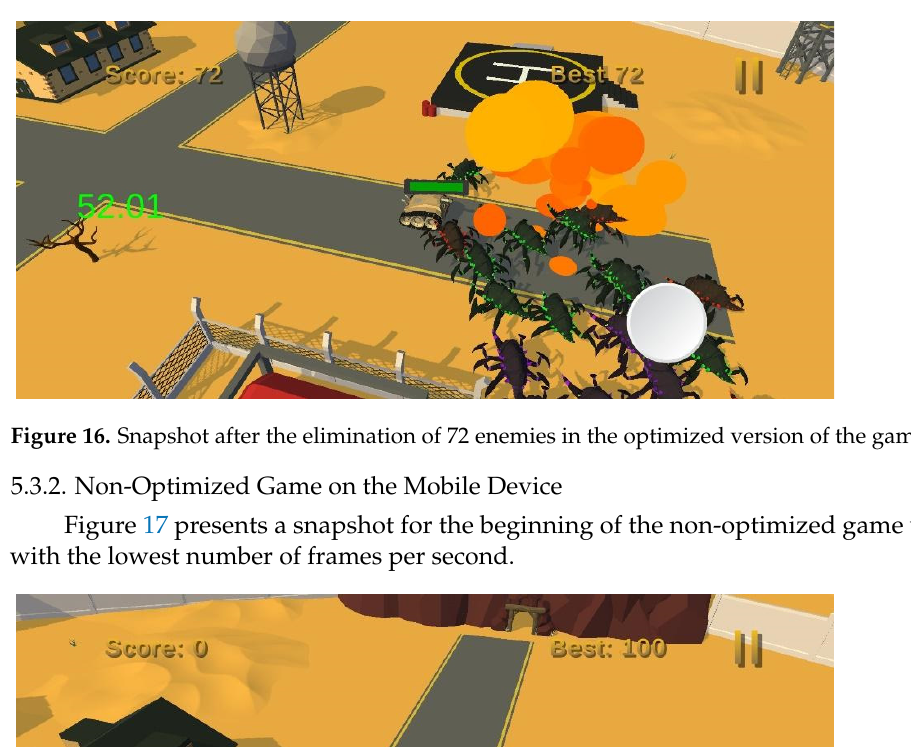
Figure 15. Snapshot after the elimination of 52 enemies in the optimized version of the game.